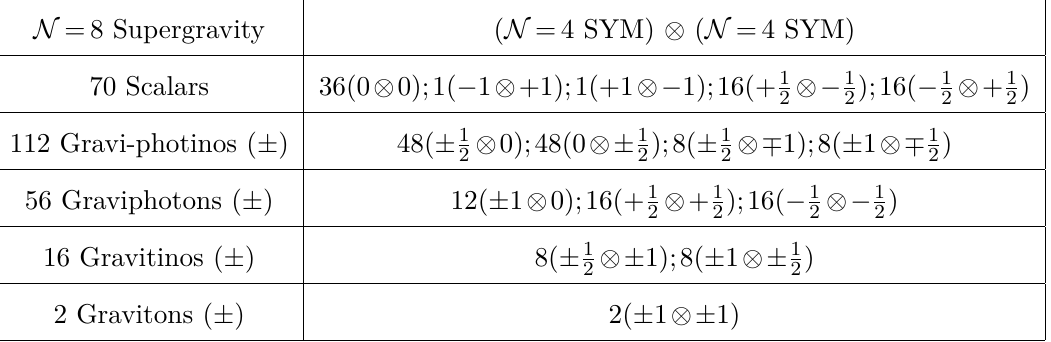
Table 2 . Factorisation of N = 8 supergravity states into N = 4 super Yang-Mills